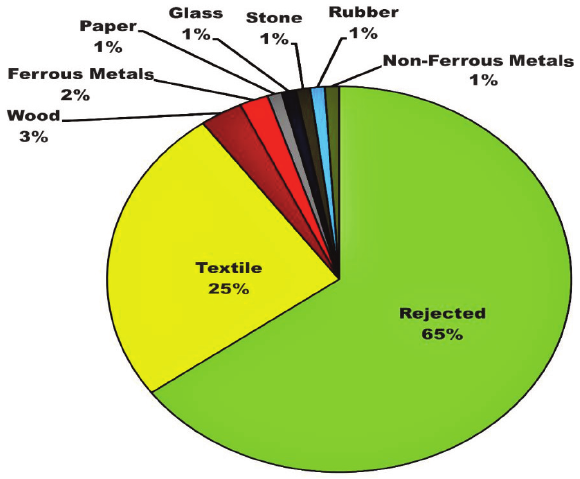
Fig. 2. Daily municipal waste distribution in